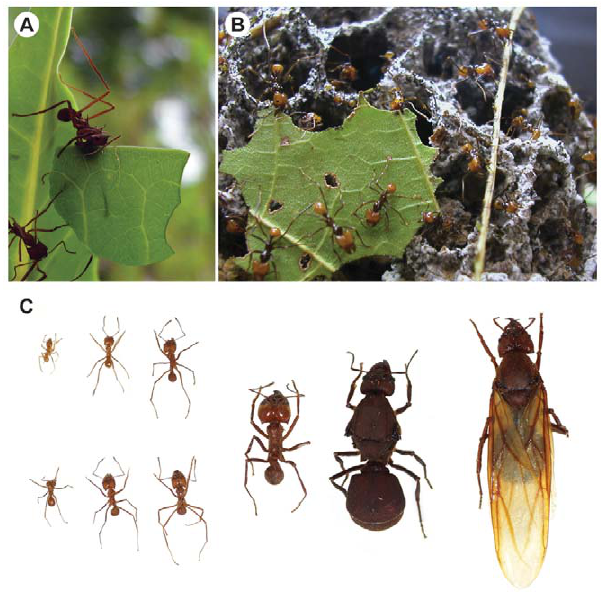
Figure 1. The leaf-cutter ant Atta cephalotes . Leaf-cutter ants harvest fresh leaf material which they cut from Neotropical rainforests (a) and use them to grow a fungus that serves as the colony’s primary food source (b). These ants display a morphologically diverse caste system that reflects a complex division of labor (c) correlated to specific tasks within the colony. These include small workers that undertake garden management and brood care, medium workers that forage leaves, large workers that can serve as soldiers, and winged sexuals that lose their wings after mating. [Photo Credits: foraging workers, Jarrod J. Scott/University of Wisconsin-Madison; fungus garden, Austin D. Lynch/